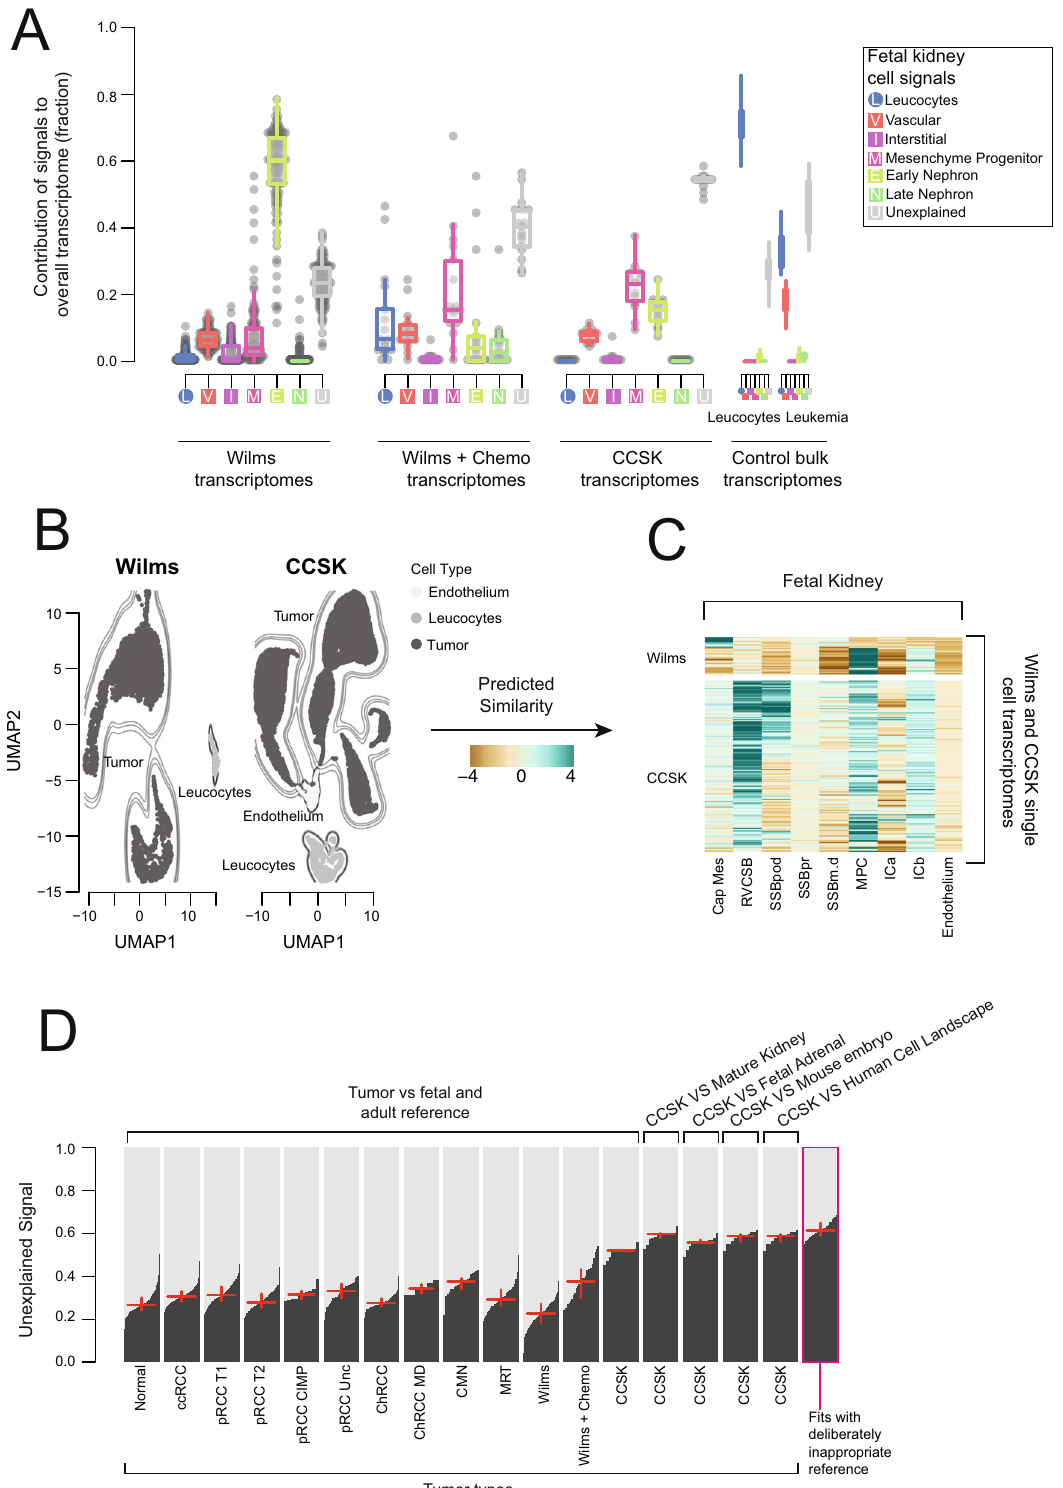
overarching transcriptional features, beyond individual